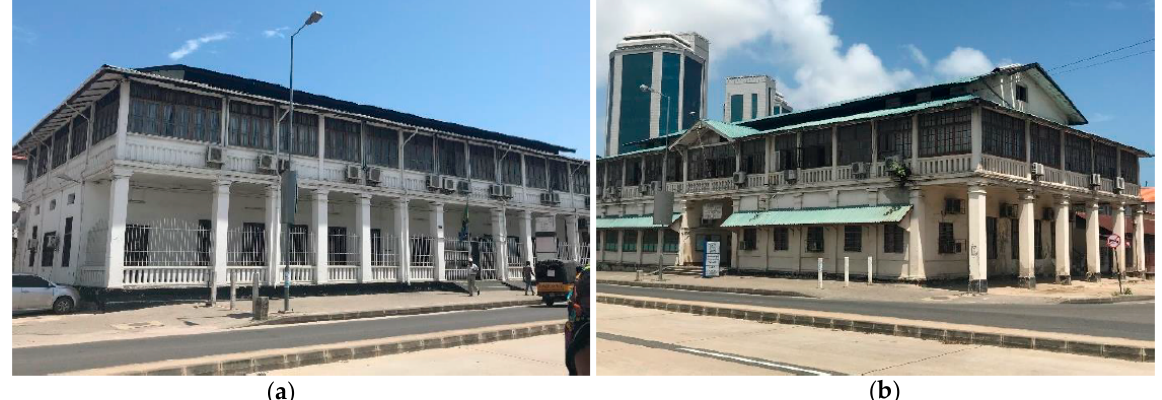
Figure 3. ( a ) NBS building ( b ) Survey and Mapping Division building; Series of German buildings with balconies covered to increase the floor plan area. (Source: Author,